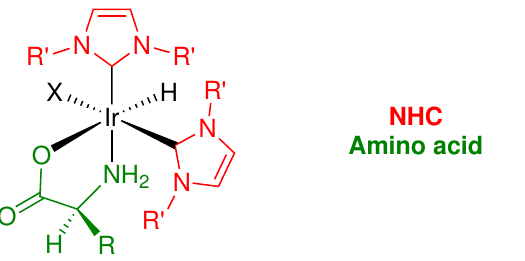
Figure 4. Structure and modularity of iridium NHC amino acid complexes reported in this article for asymmetric transfer hydrogenation of ketones, highlighting features that have potential for specific tailoring. These complexes incorporate inexpensive, easily accessible ligands, and conveniently contain a hydride on the metal center prior to initiating the